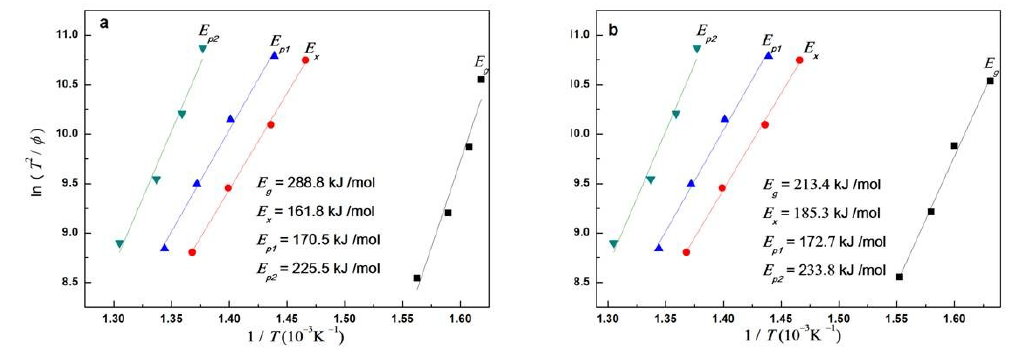
Figure 5. Kissinger plots for two materials at different heating rates: ( a ) the metallic